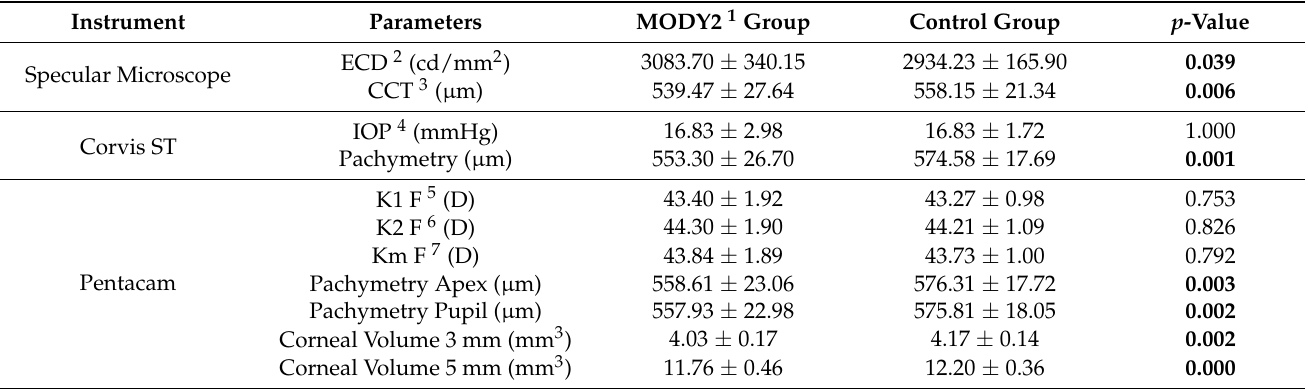
Table 3. Comparison of morphological parameters provided by Specular Microscope, Corvis ST, and Pentacam in MODY2 patients and in healthy